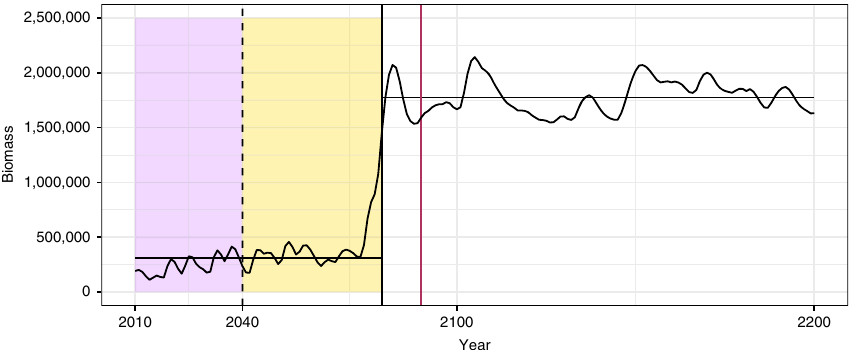
Fig. 2 Example time series of cod recovery. The recovery point (vertical solid black line) was calculated by fi tting a piecewise constant model with a single break point (horizontal black lines). The time at which fi shing pressure begins to decrease (2040, vertical dashed black line), and the time at which fi shing pressure declines to zero (vertical maroon line) are also shown. The purple box highlights the training data period used in the warning signal calculation, while the yellow box highlights the period over which warning signals of recovery were searched for (after fi shing pressure has begun to decline, but prior to the population